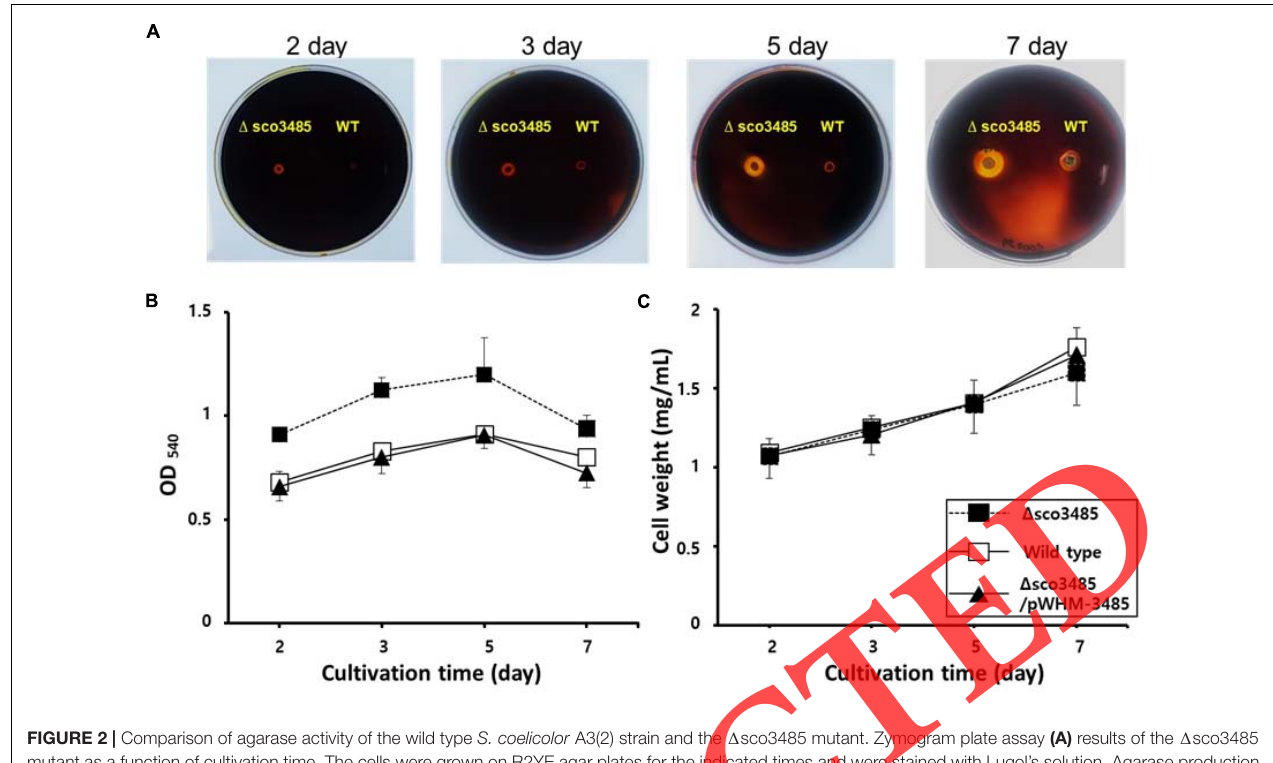
FIGURE 2 | Comparison of agarase activity of the wild type S. coelicolor A3(2) strain and the (cid:49) sco3485 mutant. Zymogram plate assay (A) results of the (cid:49) sco3485 mutant as a function of cultivation time. The cells were grown on R2YE agar plates for the indicated times and were stained with Lugol’s solution. Agarase production (B) and cell growth (C) as a function of cultivation time. Strains were grown at 28 ◦ C in RSM3 medium for 7 days and samples were collected to measure cell growth (g protein/liter) and agarase activity. All data shown are mean values from at least three replicate experiments. Error bars indicate standard deviations of the means ( n = 3). Agarase activity and cell growth of the (cid:49) sco3485 mutant ( (cid:110) ), wild type S. coelicolor A3(2) ( (cid:3) ), and complement strain ( (cid:49) sco3485/pWHM-3485) ( (cid:78)